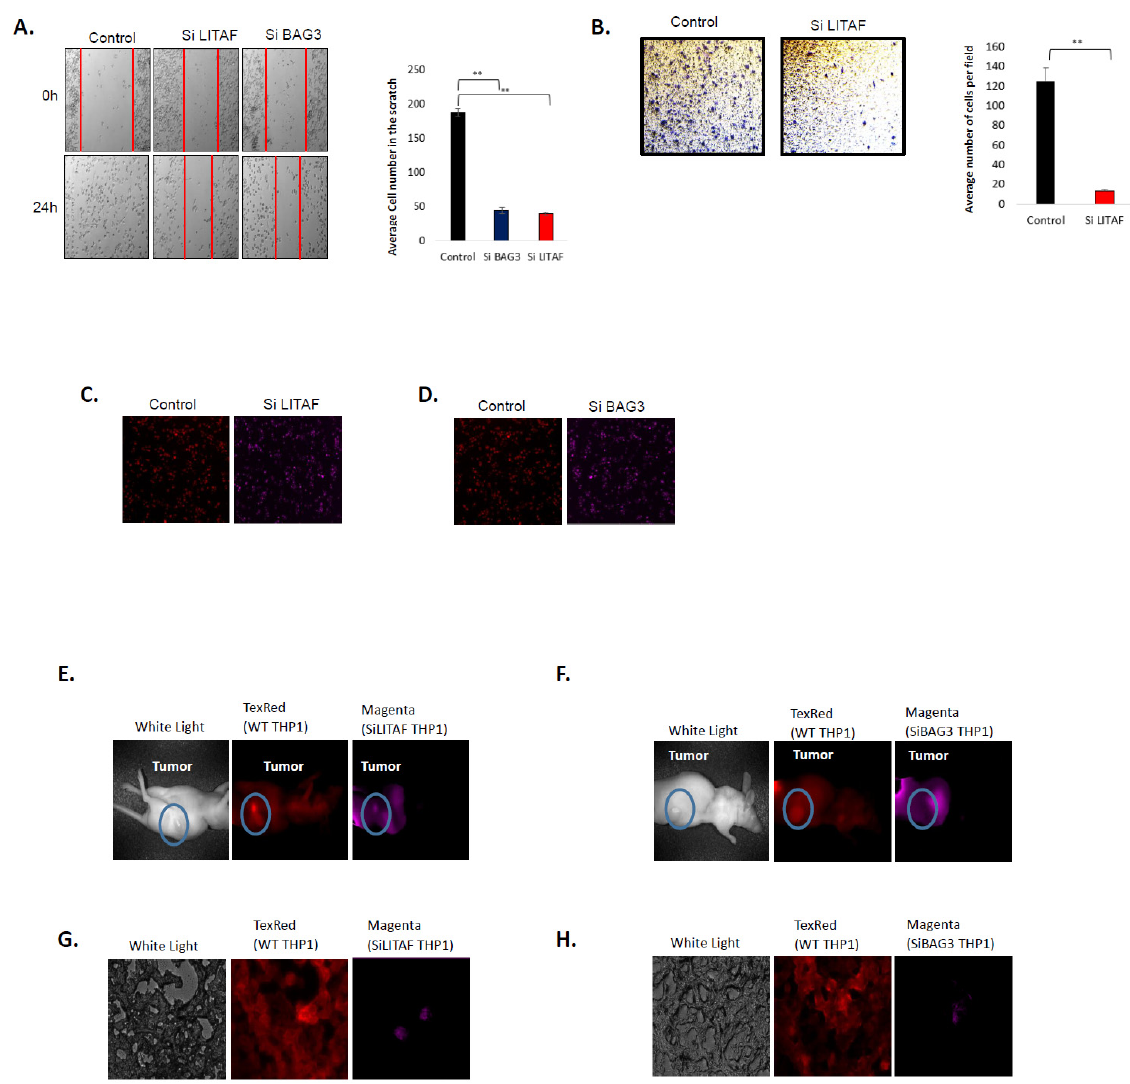
Figure 4. Silencing of Bag3 or LITAF suppresses motility and tumor infiltration of macrophages. ( A ) Silencing of Bag3 or LITAF suppresses cell motility in the wound healing assay. Differentiated THP1 macrophages were transfected with indicated siRNAs for 72 h and their migration was moni- tored by the “wound healing” assay. On the left—a representative image of cells migrated in wound healing assay, on the right (bar graph)—represents the quantification of the data. Cell numbers among the conditions were measured via Student’s t -test. ( B ) Silencing of Bag3 or LITAF suppresses cell invasion in the transwell assay. On the left—a representative image of cells migrated in transwell assay; on the right (bar graph)—demonstrates the quantification of the data using Anova. Data shown are means+/SEM of triplicates. ** p ≤ 0.01. ( E – H ) Silencing of LITAF or Bag3 suppresses the infiltration of macrophages in a mouse tumor. Cells were transfected with either Bag3 or LITAF or control siRNAs and labeled with red life color (control cells) or magenta life color (Bag3-silenced or LITAF-silenced cells). An equal number of control and silenced cells were mixed ( C , D ). Nine nude mice were first injected s.c with 106 H1975 NSCLC cells in Matrigel to form xenograft tumors. On days 8 or 9 post-injection, when tumors were formed, mice were intravenously injected with the mixture of control and LITAF-silenced ( E ) or BAG3 silenced ( F ), or PBSx1 (picture not shown) red or magenta stained differentiated THP1 macrophages. On day 10 tumors were collected and sliced and pictures were taken using a fluorescent microscope ( G , H ). Whole mouse images of the experiment are described in C and D. Image of control (red) or siLITAF (magenta) ( E ) or siBAG3 (magenta) ( F ) THP1 distribution in the body of the